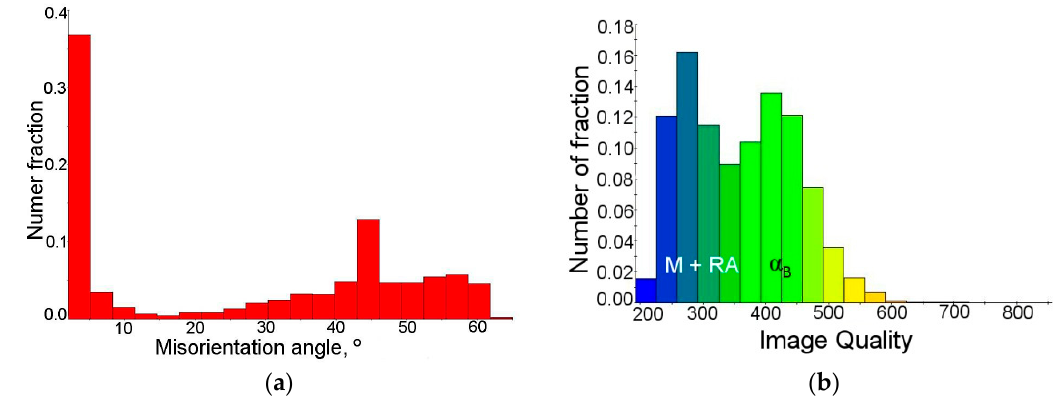
Figure 9. Distribution of misorientation angle ( a ) and IQ parameter ( b ) of the sample elongated to 5%.